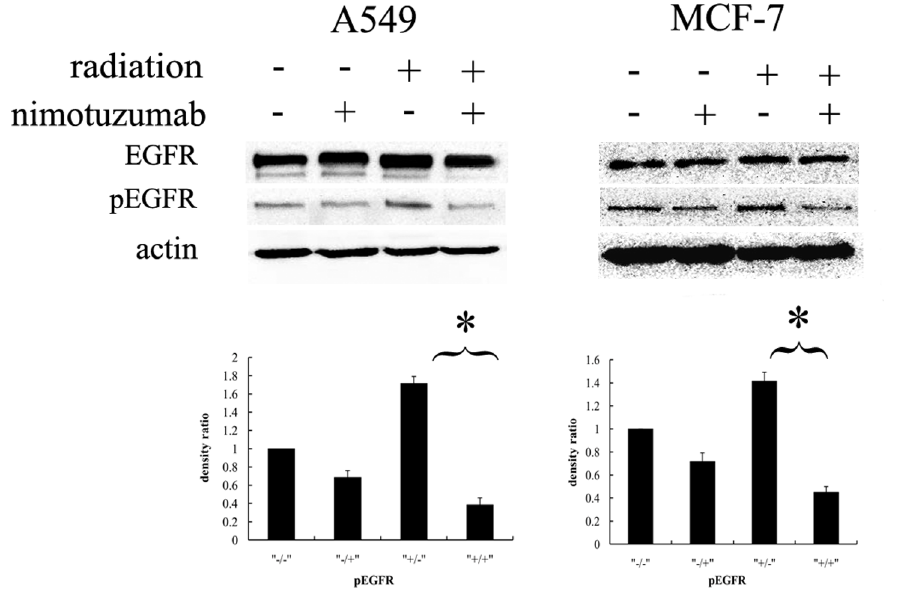
Figure 2. EGFR activation after treatment with nimotuzumab and radiation. A549 cells and MCF-7 cells were pretreated with or without nimotuzumab for 24 h before radiation with 4 Gy. Cells were harvested and lysed at 2 h after radiation. The lysates underwent electrophoresis and were incubated with antibodies against EGFR, pEGFR and b -actin. The column charts below are quantification of the bands based on densitometric analysis. Each bar represents the mean 6 SD of relative density ratio to the control. * indicates significant difference (P , 0.05).